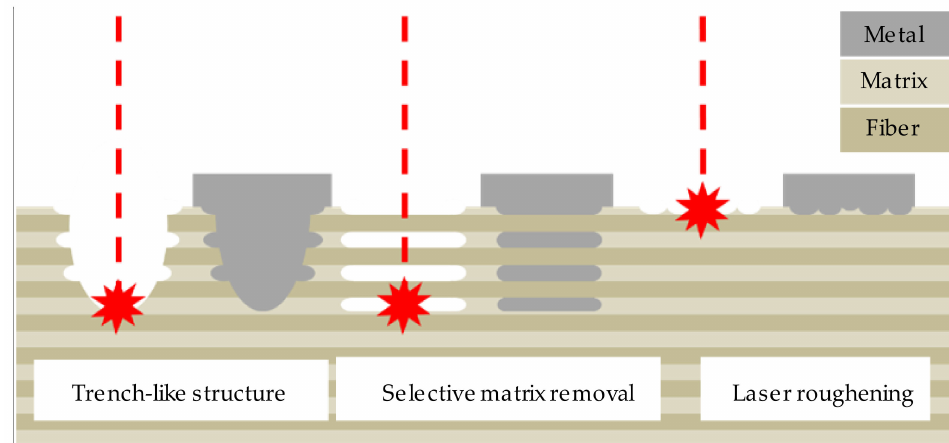
Figure 2. Scheme of the used laser strategies before and after the application of the thermally sprayed metal